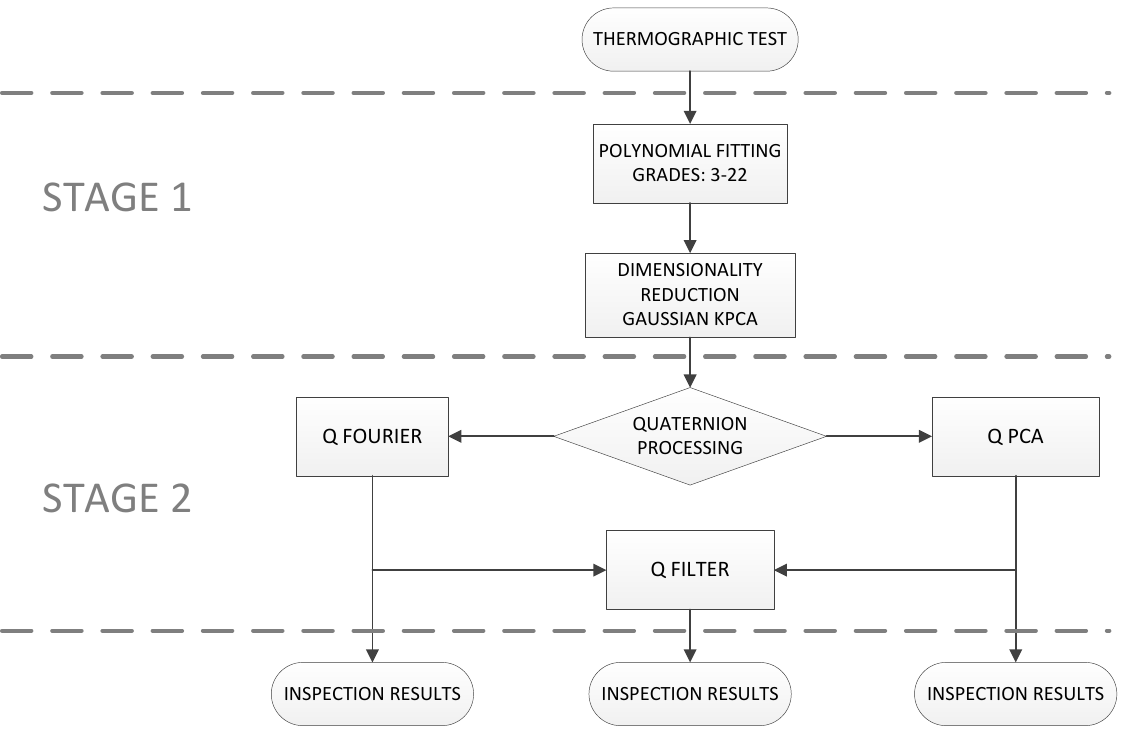
Figure 1. Methodology followed in the proposed quaternionic NDT